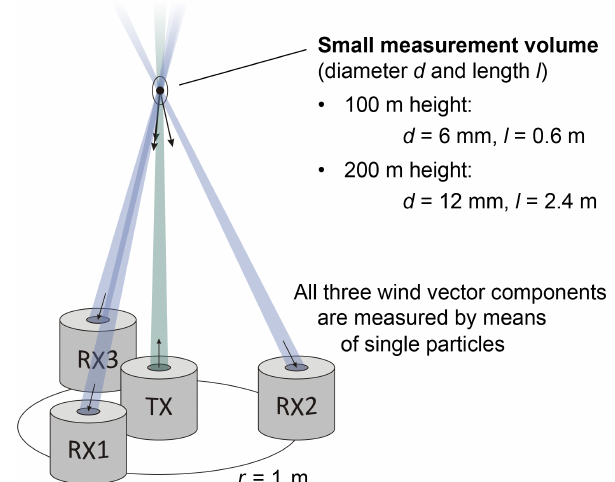
Figure 2. Principle of the novel bistatic lidar consisting of one transmitting unit TX (green beam) and three receiving units RX (blue